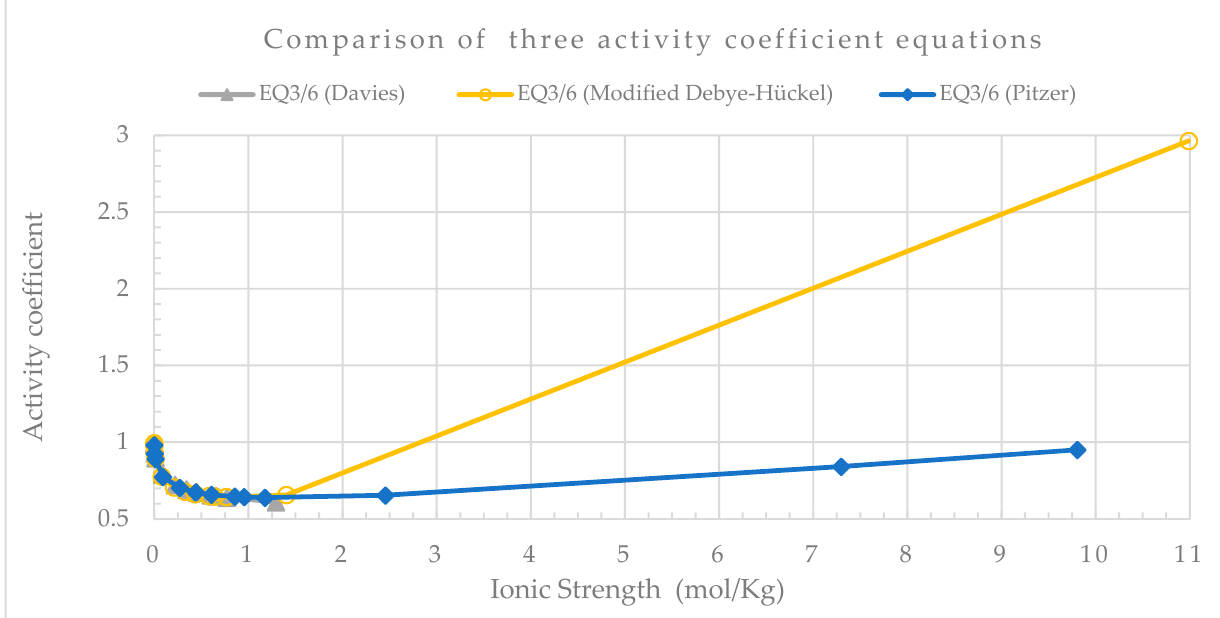
Figure 13. Dependence of the activity coefficient of Na + on the ionic strength in a range up to 0.5 mol/kg through EQ3/6.